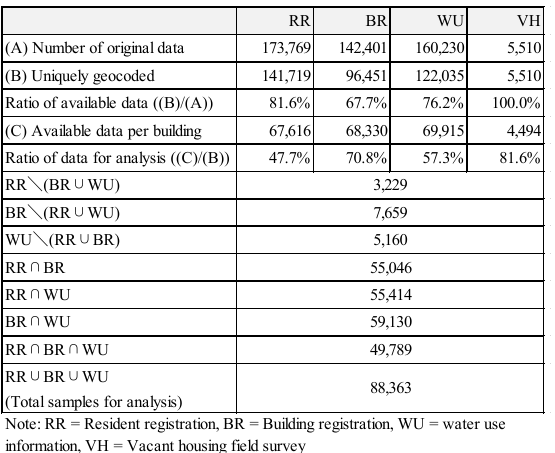
Table 1. Summary of data